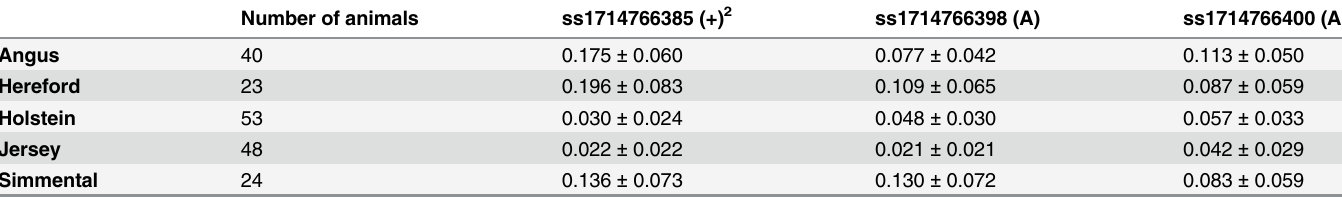
Table 3. Frequency of allele associated with high ovulation rate by breed for three polymorphisms. 1